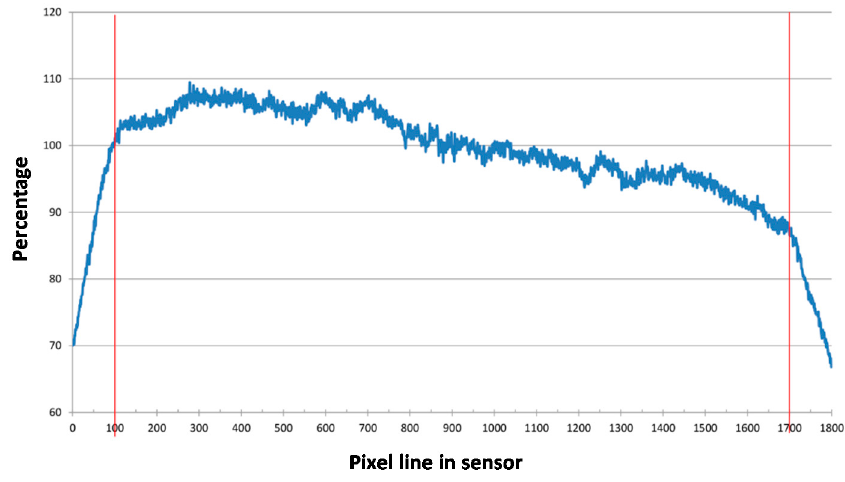
Figure 5. Sensor response drop on edge pixels of VNIR camera flight line, shown by red line.